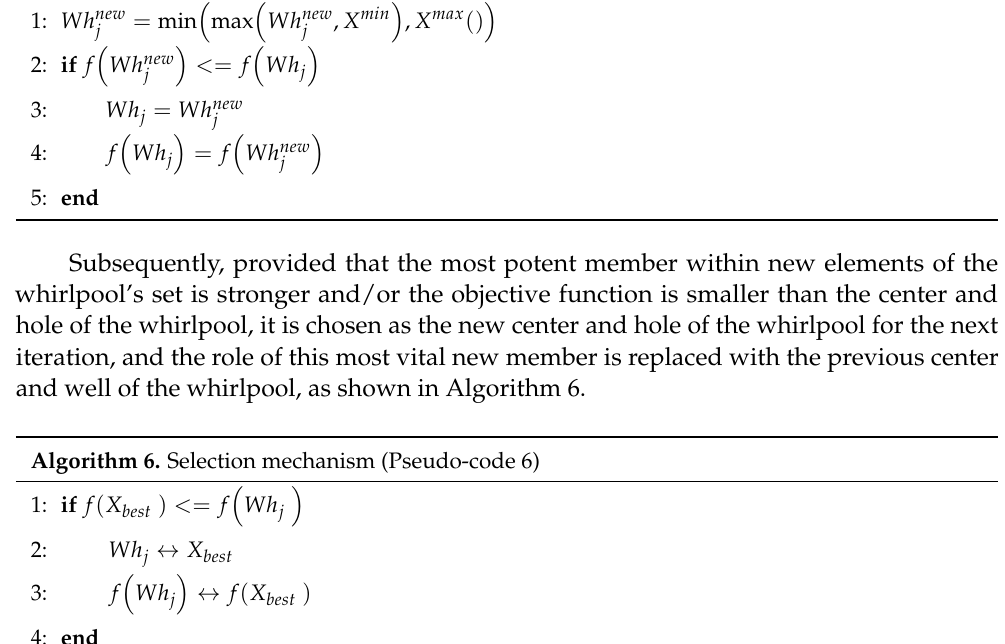
Algorithm 5. Whirlpools’ updating process (Pseudo-code 5)